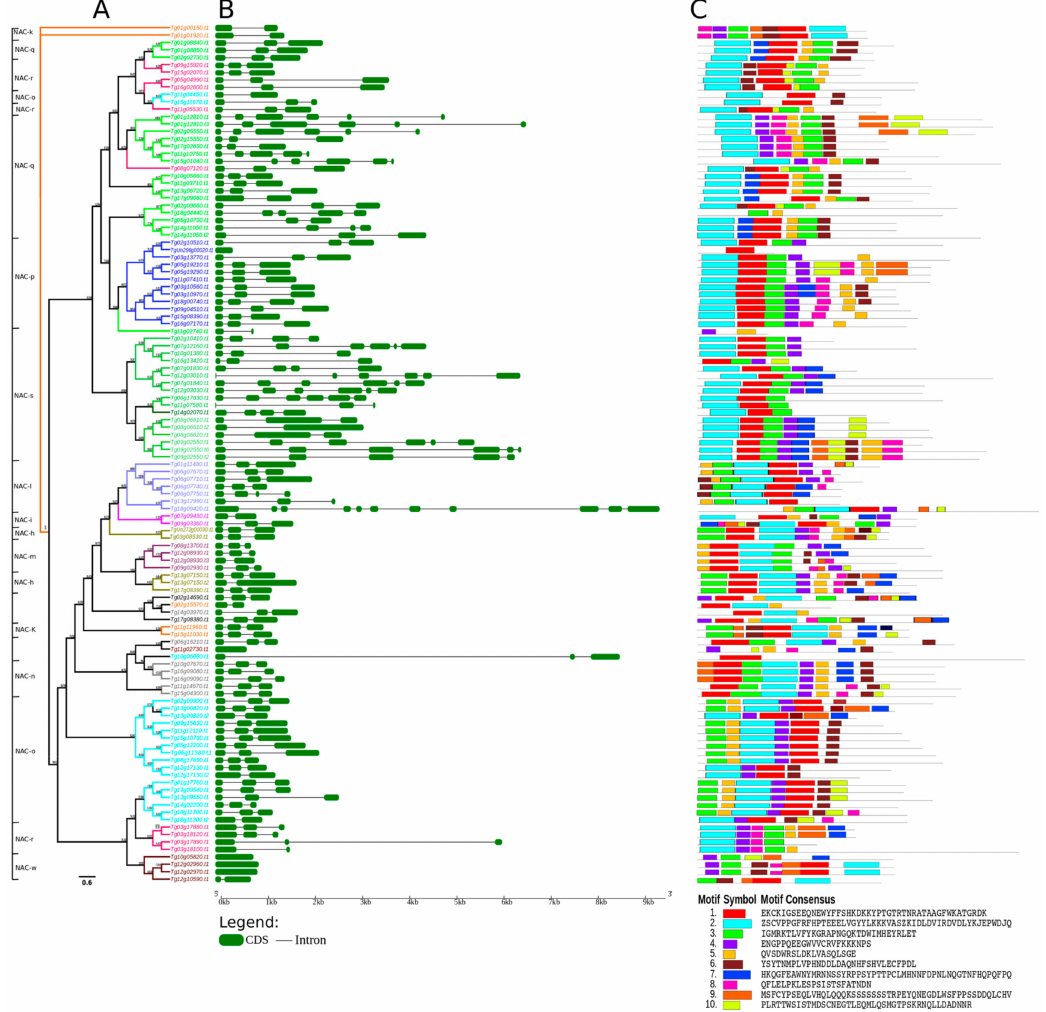
Figure 2. Phylogenetic relationship, gene structure, and motif composition of T. grandis NAC genes. ( A ) Maximum-likelihood phylogenetic tree rooted of 116 teak NAC proteins was constructed using Q-Tree v1.6.9 and ultrafast bootstrap, with 1000 replicates. ( B ) Exon–intron structure represented in kilobase (kb) scale of 107 TgNAC genes. ( C ) Schematic representation of the conserved motifs in the NAC proteins from teak. Green boxes and black lines represent exons and introns,